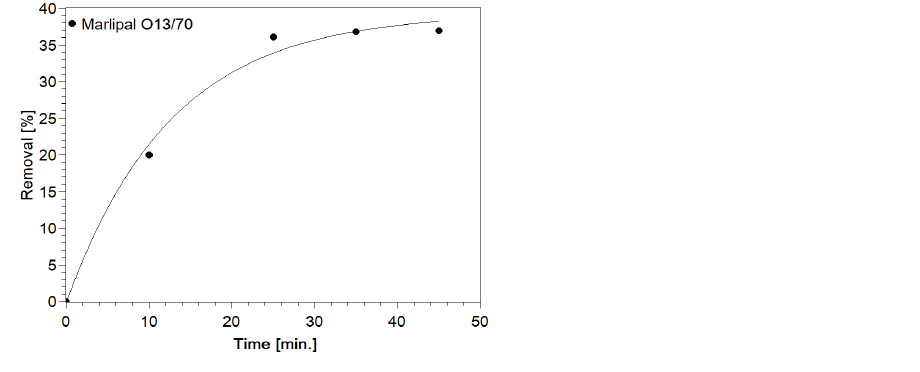
Figure 3. Flotation experiment with PET microplastic particles. Initial conc.: 750 mg/L. Gas-flow rate: 10.4 mL N 2 /min.